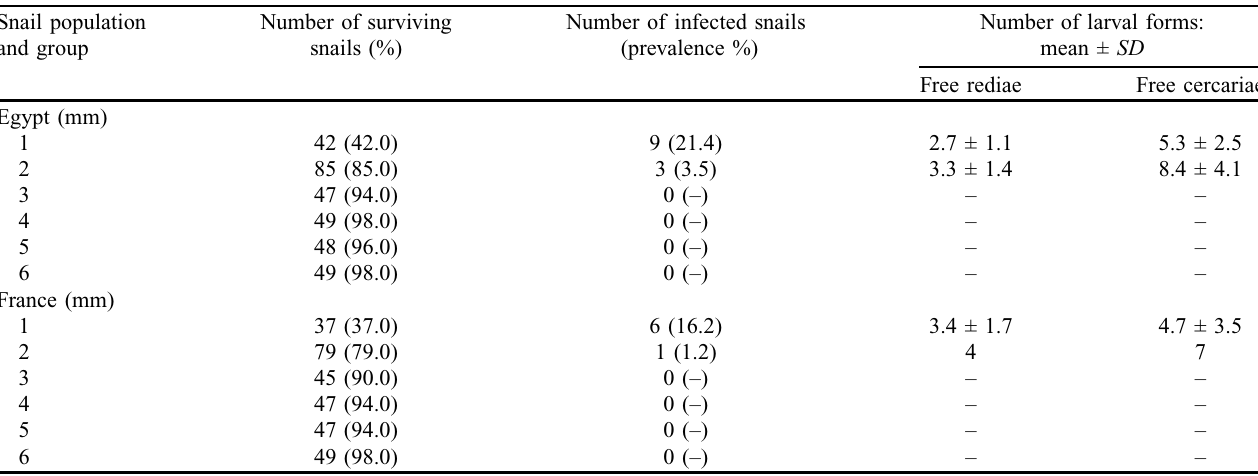
Table 1. Snail survival on day 30 post-exposure, prevalence of Calicophoron daubneyi infection, and numbers of free rediae and free cercariae in 12 groups of Pseudosuccinea columella subjected to individual quinque-miracidial exposures and dissected on day 42. Fifty snails of each group were exposed on day 1, except for 100 snails in each 1-mm and 100 in each 2-mm group.